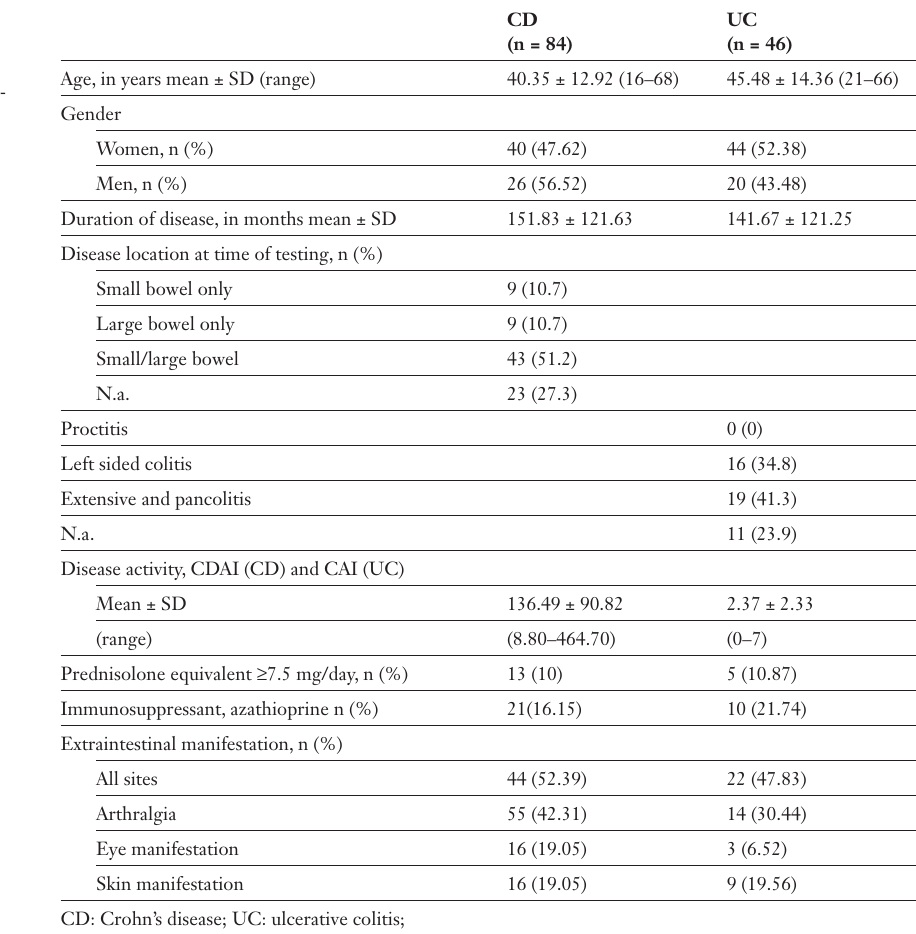
Patients’ disease characteristics and medication at base- line.